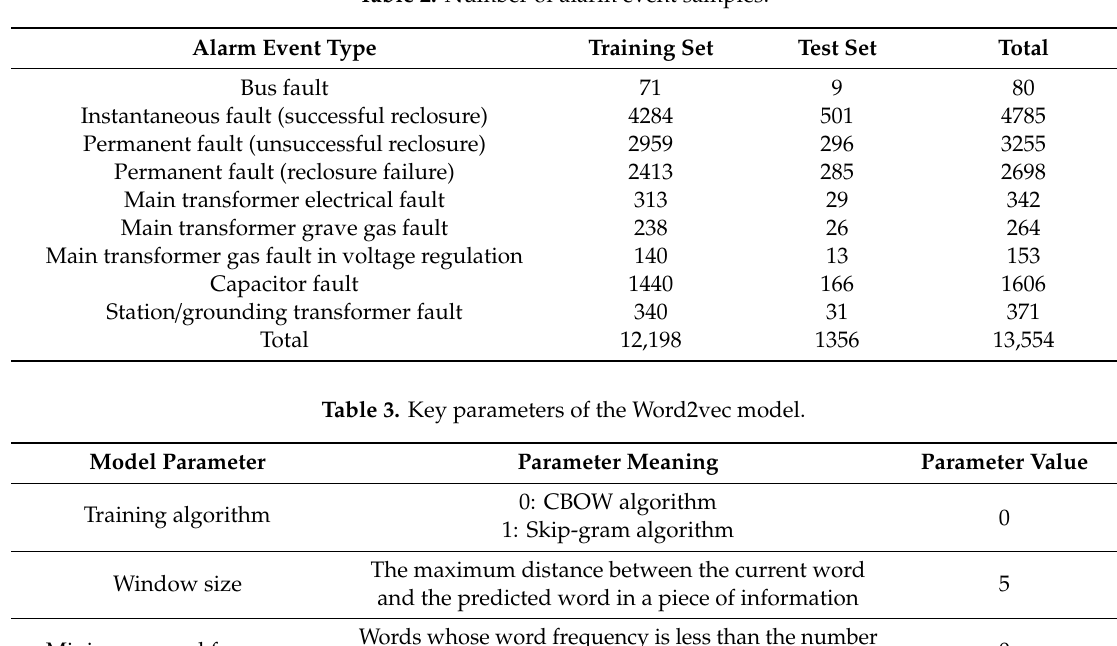
Table 2. Number of alarm event samples.